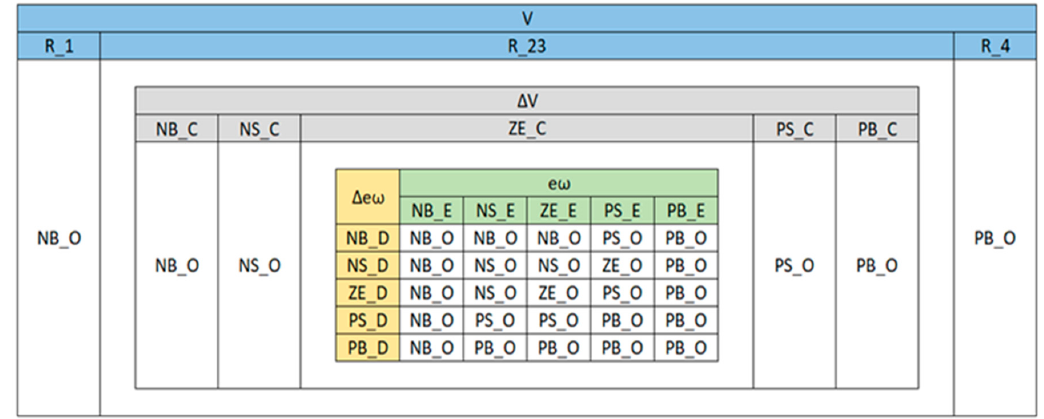
Figure 15. Outline of the control rules at each hierarchical level.